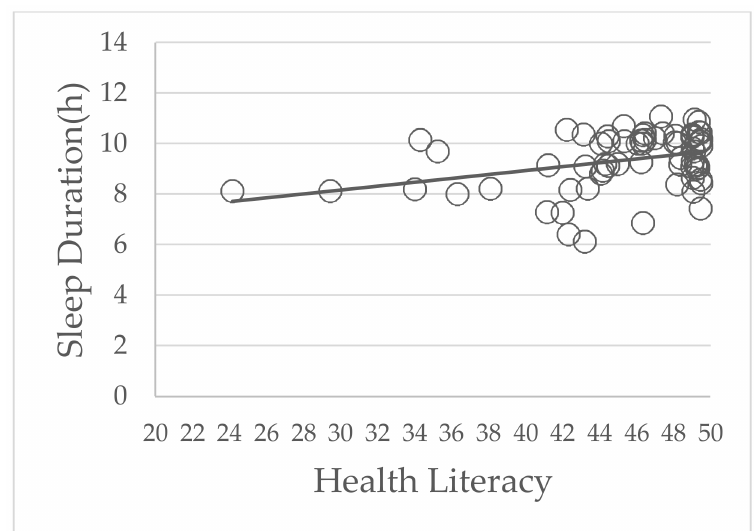
Figure 2. The correlation between parents’ health literacy and their children’s sleep duration in the low health literacy group. The p value was 0.01 and the correlation coefficient (r) was 0.32.